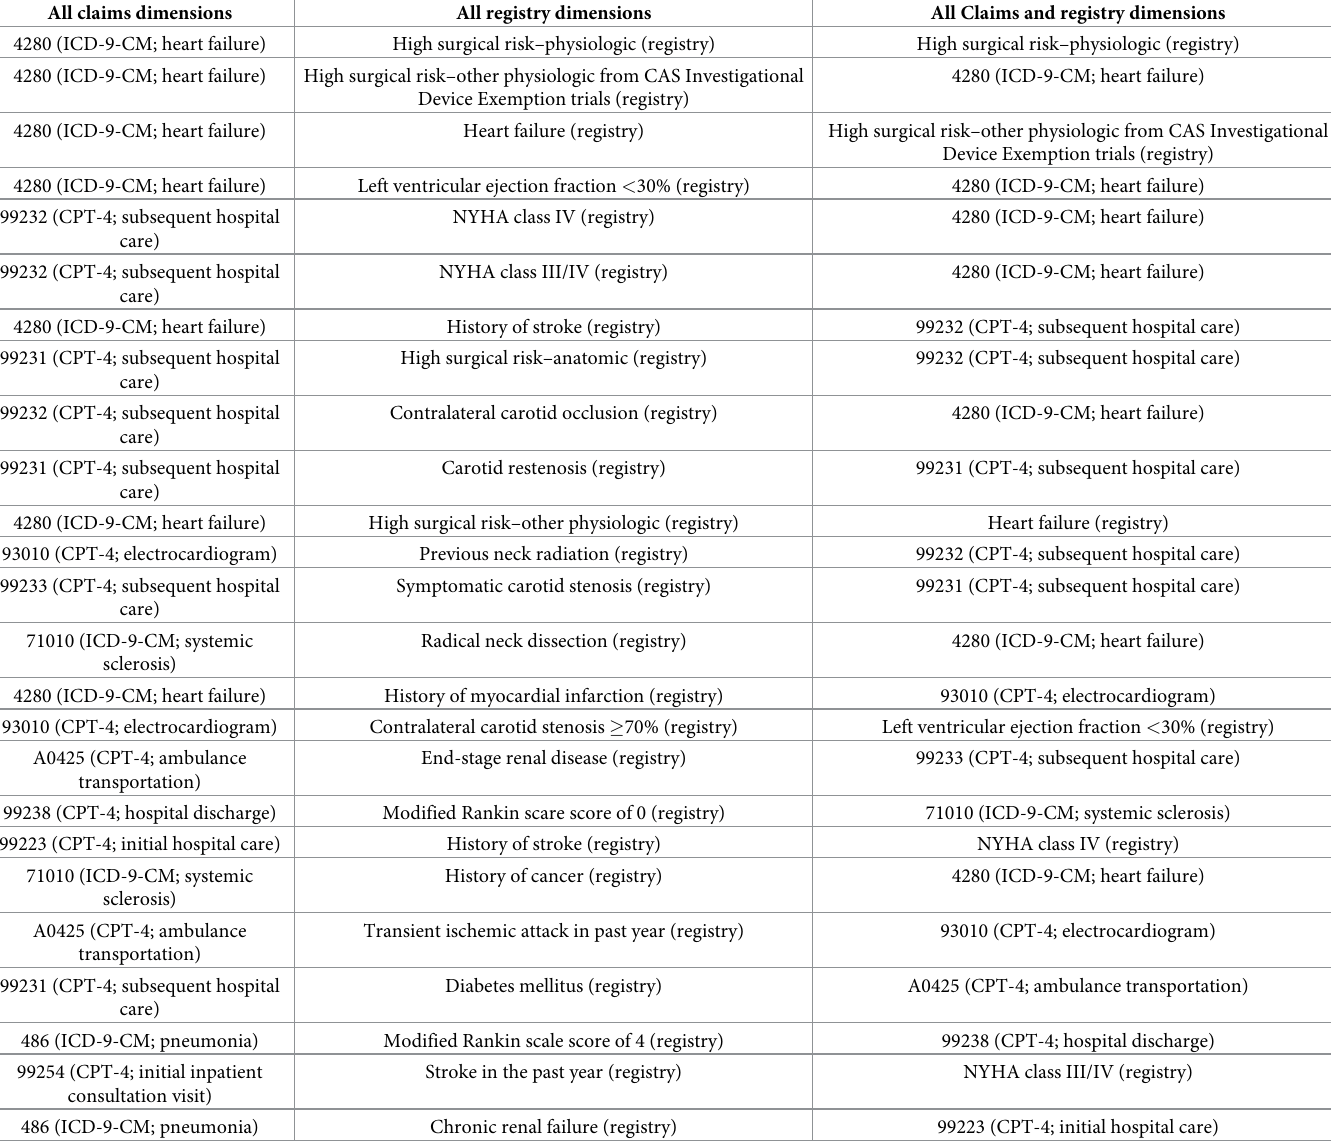
Table 3. Top 25 variables identified by the high-dimensional propensity score algorithm as having the greatest potential to cause confounding. All claims